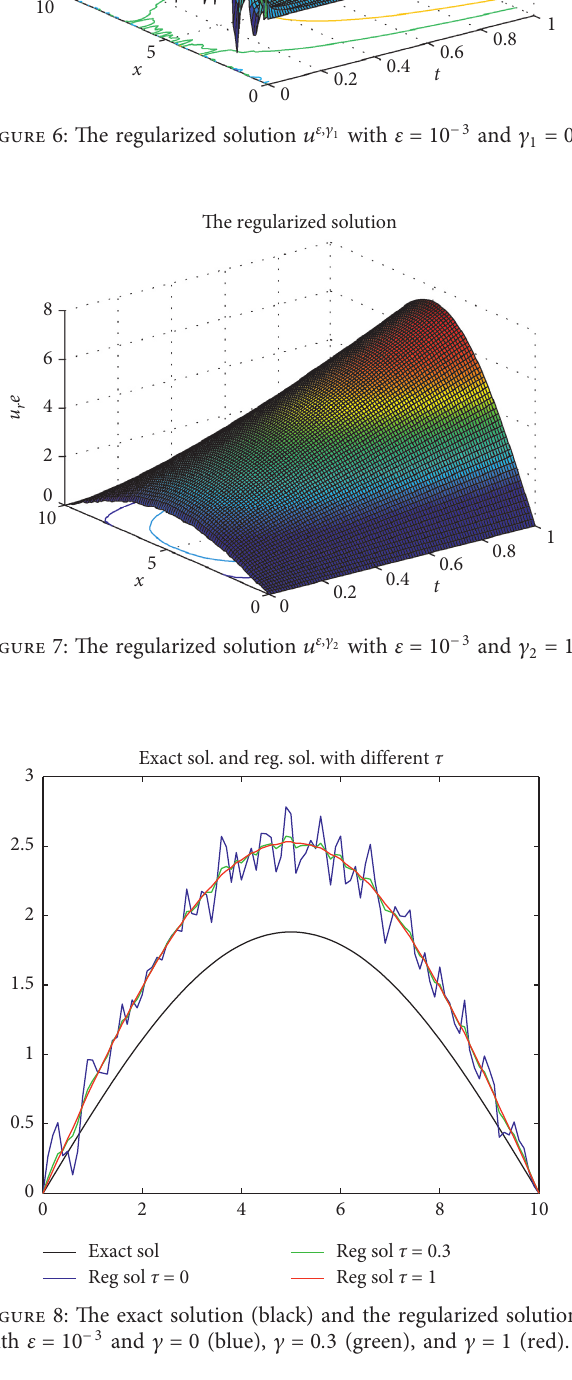
Figure 6: The regularized solution u ε , c 1 with ε � 10 − 3 and c